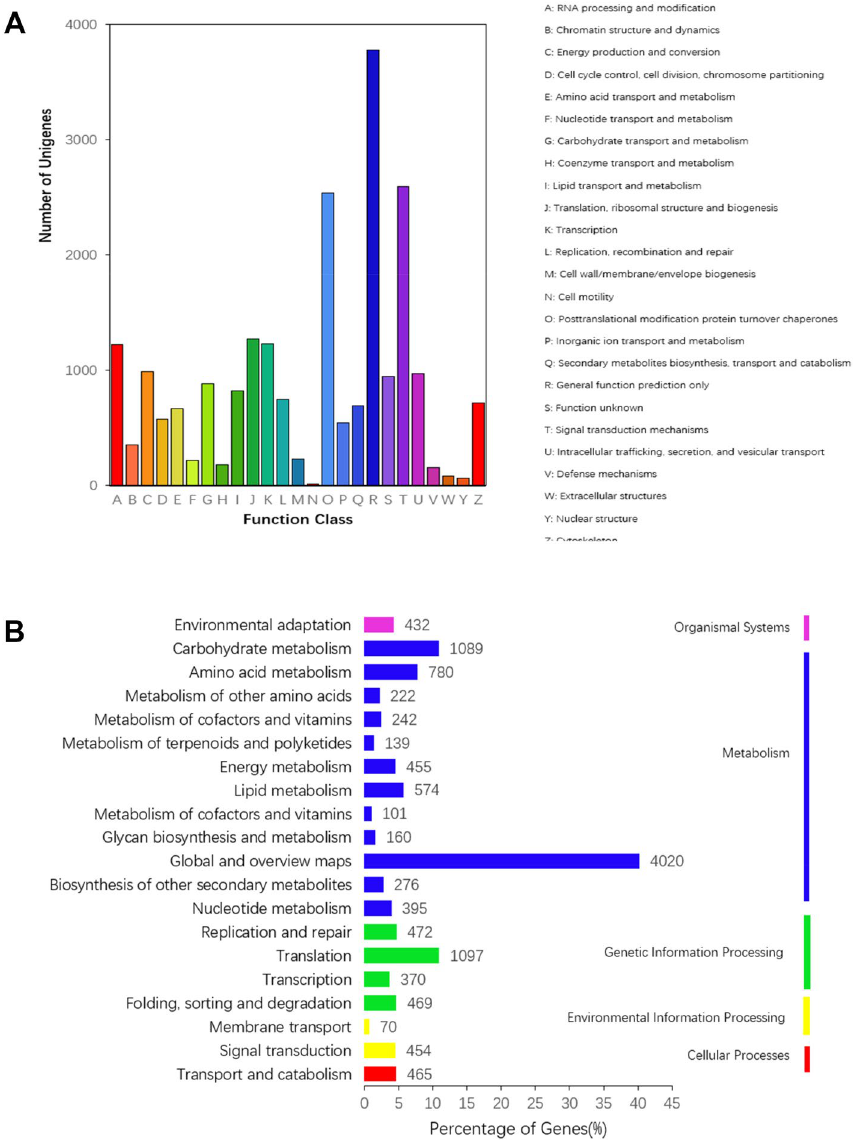
Figure 4. (A) KOG functional classification of S. incisa unigenes (The y-axis indicates the number of unigenes in a specific functional cluster. The x-axis indicates the KOG functional classification). ( B) KEGG metabolic pathway of S. incisa (the y-axis is the name of the KEGG metabolic pathway, and the x-axis is the ratio of the number of genes. https ://www.genom e.jp/dbget -bin/www_bget?pathw ay+map01